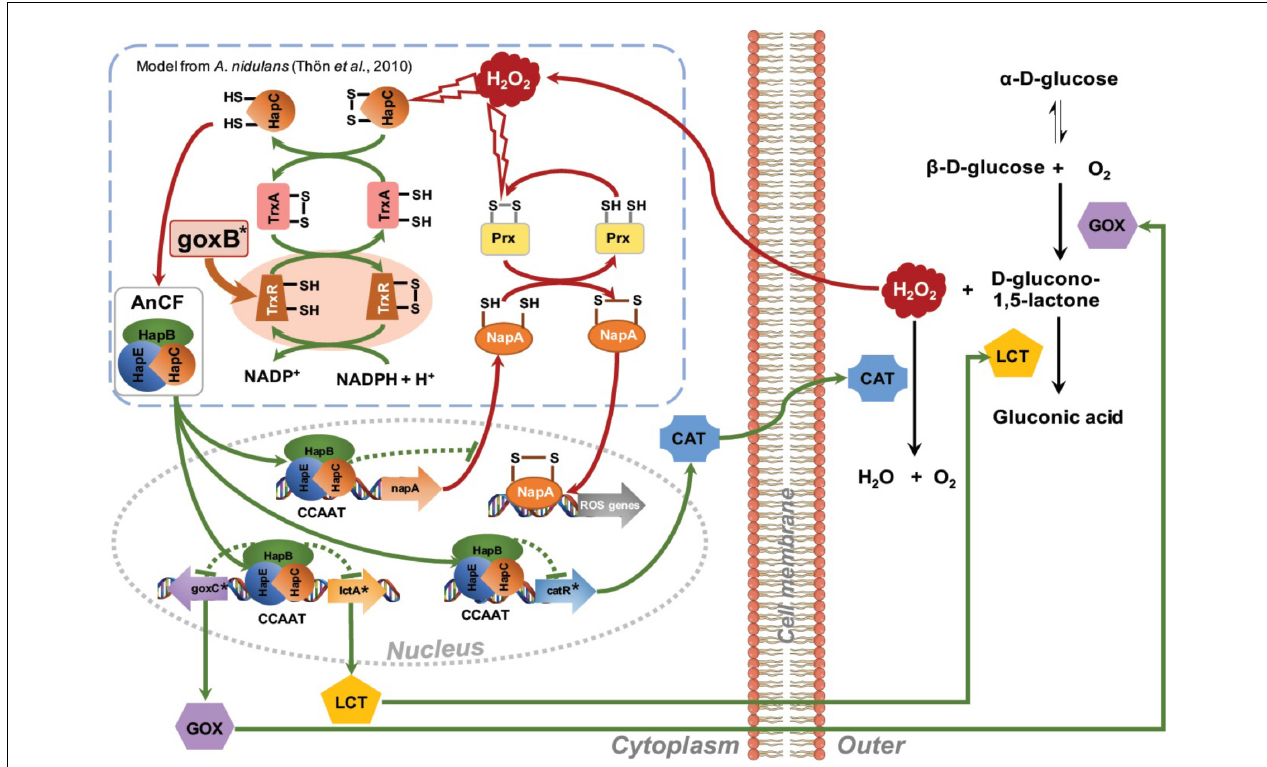
FIGURE 7 | Proposed network for regulation of the glucose oxidase system. Amplification of the H 2 O 2 signal is achieved via a positive feedback loop. H 2 O 2 induced oxidative modification of thiol groups in ROS sensitive regulatory proteins such as AnCF complex (Thön et al., 2010) or NapA (Marinho et al., 2014) leads to activation of goxC expression. Outside the cell an increase GOx activity may lead to a further increase in turnover of glucose in gluconic acid and H 2 O 2 . The increased extracellular